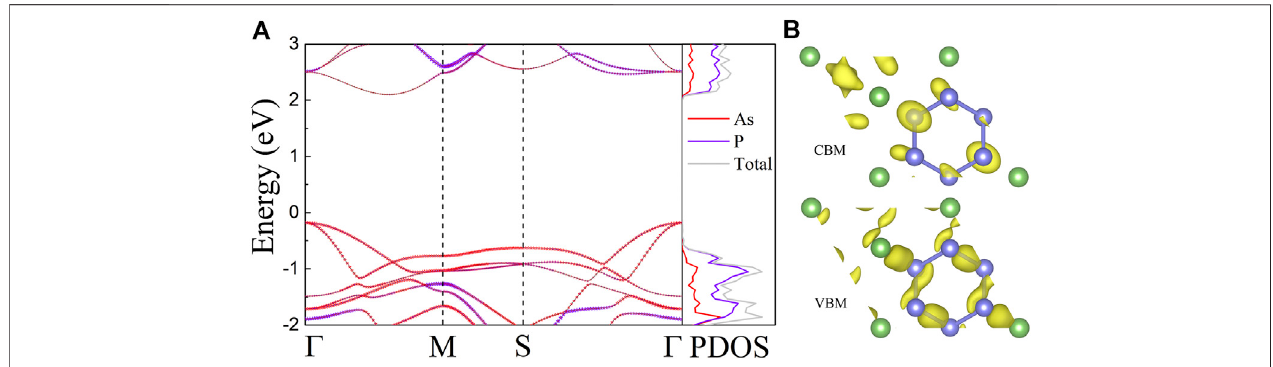
FIGURE2|(A) Calculatedorbital-resolvedbandstructuresandcorrespondingDOSofAsP 3 monolayer.ThecontributionfromAs(red)and p (purple)atomsweight the colors of band structures. (B) The partial charge densities of DOS.